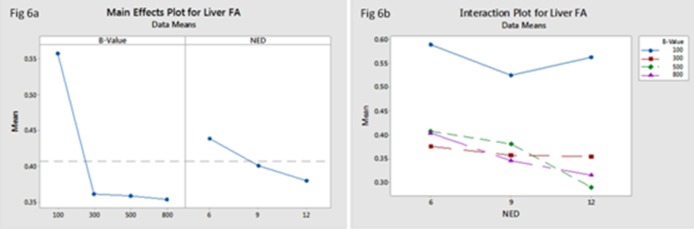
The main effect of b-values and NED on liver FA (a) showed that liver FA value reduced with increased b-values, even though the FA value of liver slightly reduced with increased NED, there was no statistically significant difference. The interaction between b-values and NED on liver FA (b) showed that selected b-value = 100s/mm2 no matter what values the NED were, theliver ADC values were the highest.